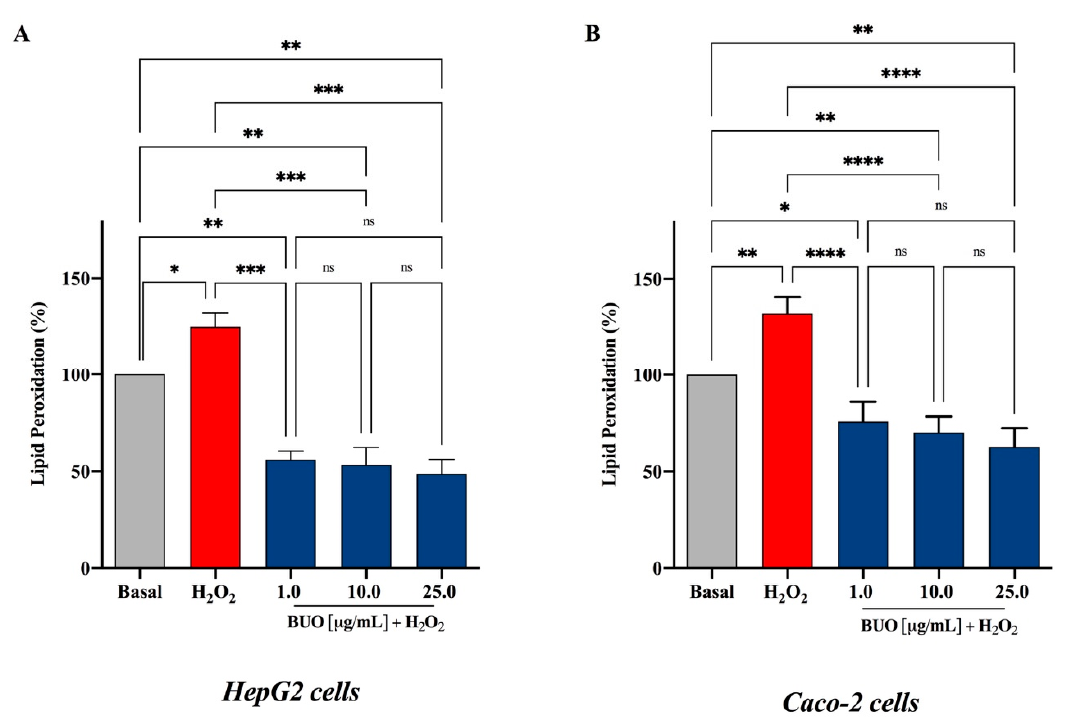
Figure 4. Evaluation of the effects of the BUO extract on H 2 O 2 -induced lipid peroxidation levels in human hepatic HepG2 cells ( A ) and intestinal Caco-2 cells ( B ) as assessed by intracellular MDA levels. The data points represent the averages ± SD of six independent experiments in duplicate. All data sets were analyzed by One-way ANOVA followed by Tukey’s post-hoc test. ns: not significant; (*) p < 0.5, (**) p < 0.01, (***) p < 0.001, (****) p < 0.0001. Basal: untreated cells.